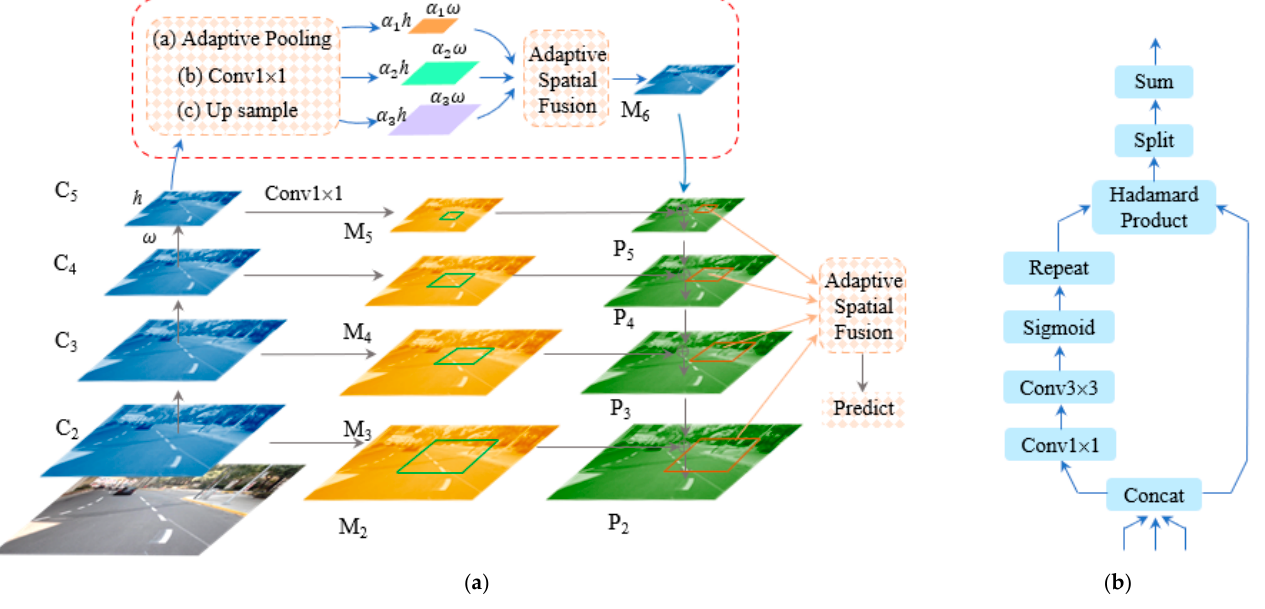
Figure 6. ( a ) is AugFPN architecture. ( b ) is adaptive spatial fusion architecture.